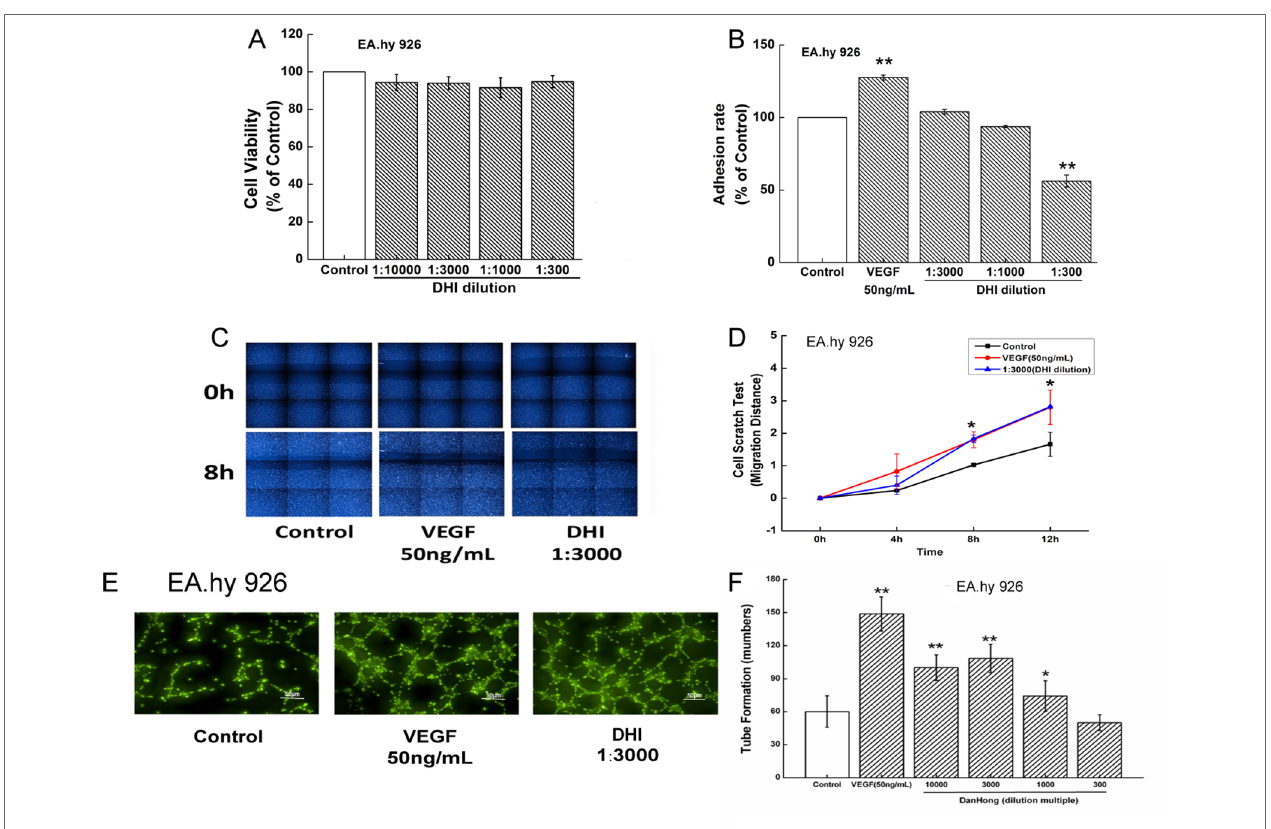
FIGURE 3 | DHI improved endothelial cells function. (A) EA.hy926 viability was determined by Cell Counting Kit-8 assay under different concentrations of DHI, none dilution caused any significant viability changes. (B) VEGF (50 ng/ml) significantly increased adhesion ability. Lower concentrations (3000, 1000-fold dilution) of DHI did not change the adhesion ability. However, higher concentration (300-fold dilution) of DHI decreased the hy926 adhesion ability compared with the control group. (C) Representative images of the wound healing assay in EA.hy926 cells. (D) Quantitative analysis of the migration distance, VEGF or DHI (3000-fold dilution) promote the cell migration after 8 h. (E) Microscopic images showing tube formation of EA.hy926 cells. (F) After incubating for 12 h with DHI, different dilution folds of DHI promoted angiogenesis in EA.hy926 cells. Data represent the mean ± SD. *P < 0.05, **P < 0.01, compared with the control